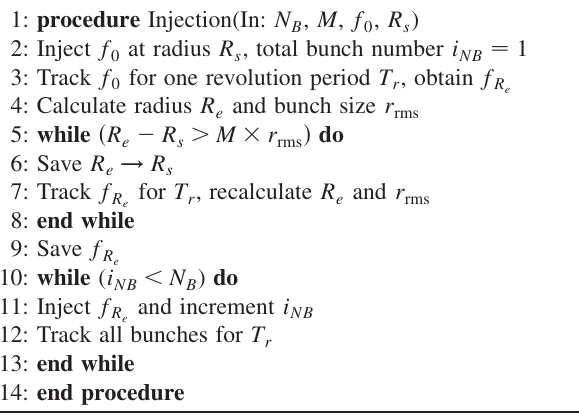
FIG. 3. (Color) The radial space-charge field E tiple Gaussian beams at the central beam region. The beams are truncated at 10% of their charge density and rms beam size is ¼ 1 : 0 (mm). All graphs are on the same r rms